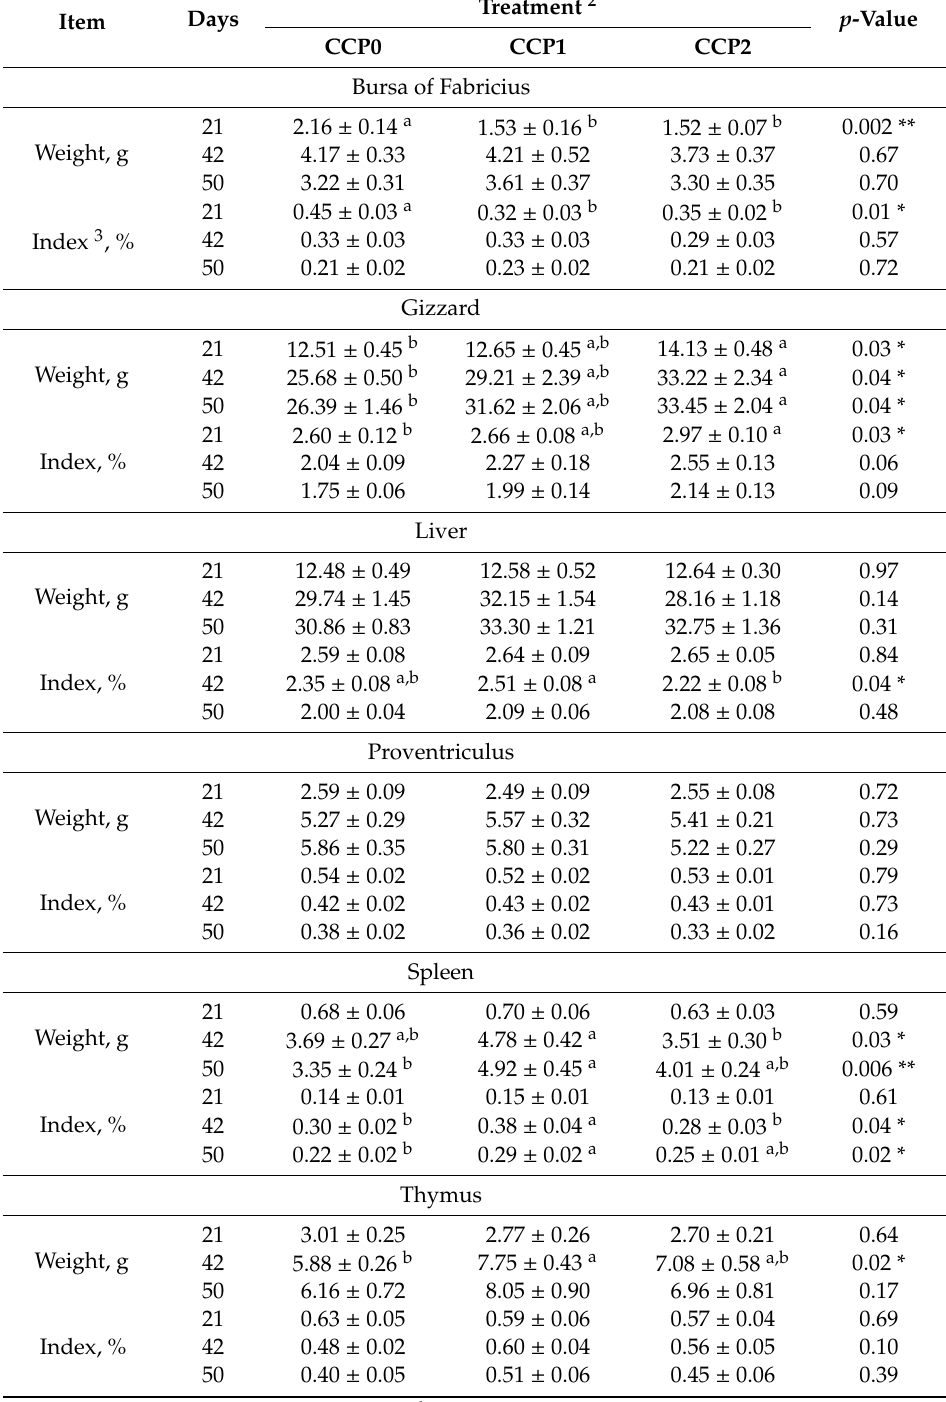
Table 4. Organ weight ( ± SEM 1 ) of yellow broilers fed with diets containing di ff erent contents of Camellia oleifera cake polysaccharides from 1 to 50 days of